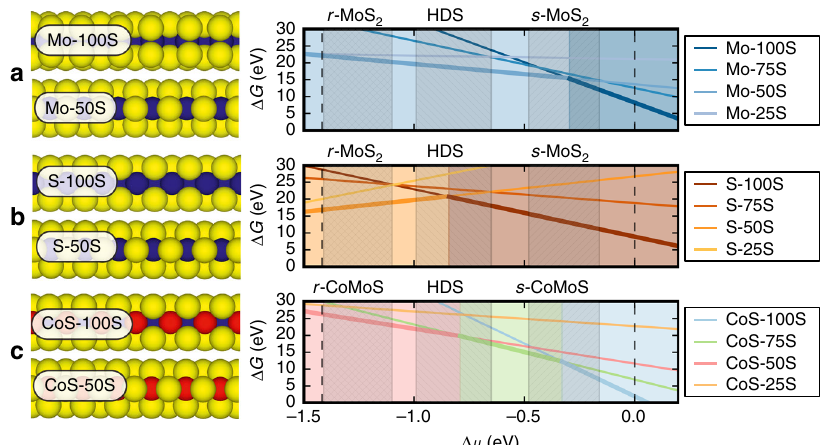
Fig. 4 Ball models and calculated edge stabilities of Au-supported MoS 2 and CoMoS nanoclusters. a Mo-edge, b S-edge, and c CoMoS S-edge terminations of MoS 2 and CoMoS nanoclusters illustrating different S coverages. Mo: blue, S: yellow, Co: red. Phase diagrams (right panels) obtained by means of DFT calculations and ab initio thermodynamics analysis of Au-supported MoS 2 and CoMoS nanocluster models (see Methods). The Gibbs free energy of formation ( Δ G ) of the nanoclusters has been evaluated for each edge type and coverage as a function of the chemical potential of sulfur ( μ s ). Hashed areas indicate regions of μ s estimated to be representative of the indicated experimental conditions (i.e., reducing, sul fi ding, or